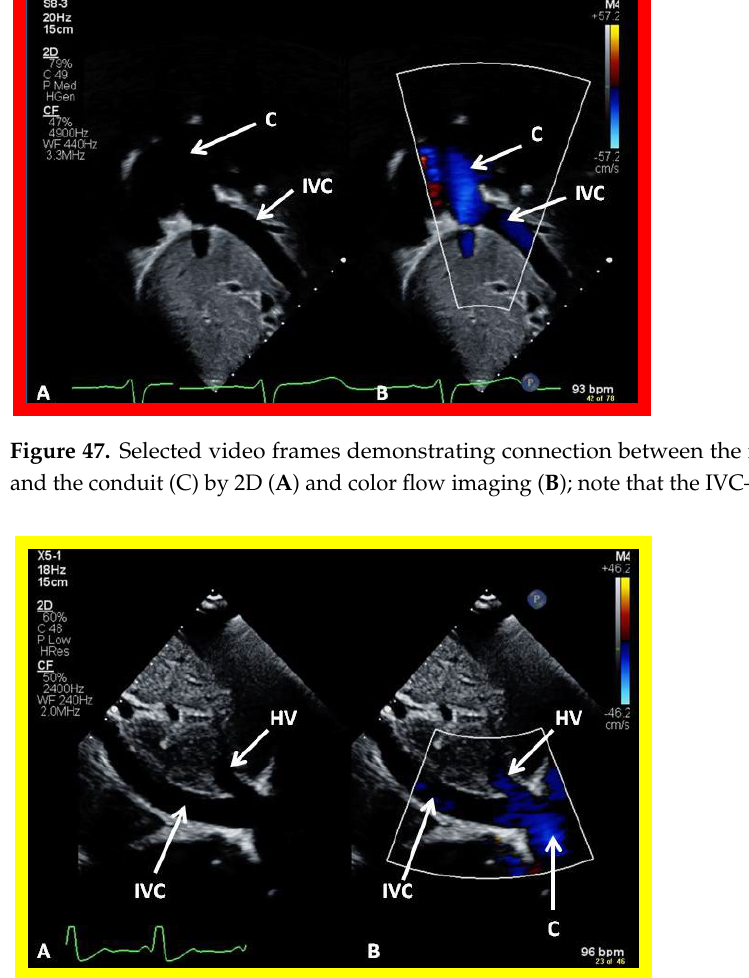
Figure 48. Selected video frames from subcostal view demonstrating connection between the inferior vena cava (IVC) and the conduit by 2D ( A ) and color flow imaging ( B ); note that the IVC to conduit (C) connection is wide